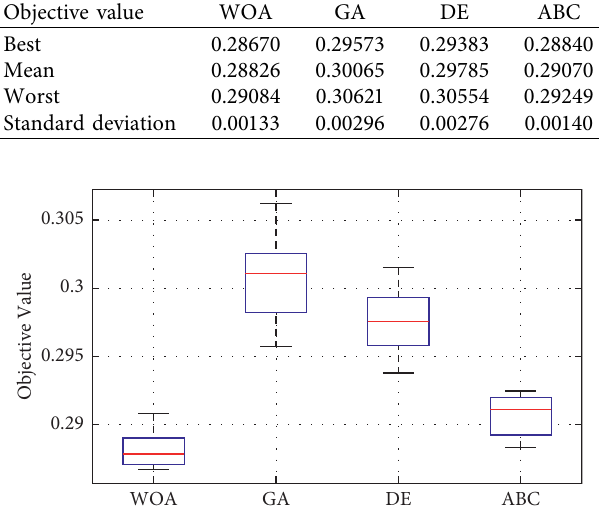
Figure 12: Boxplots of different metaheuristic algorithms for the objective value.